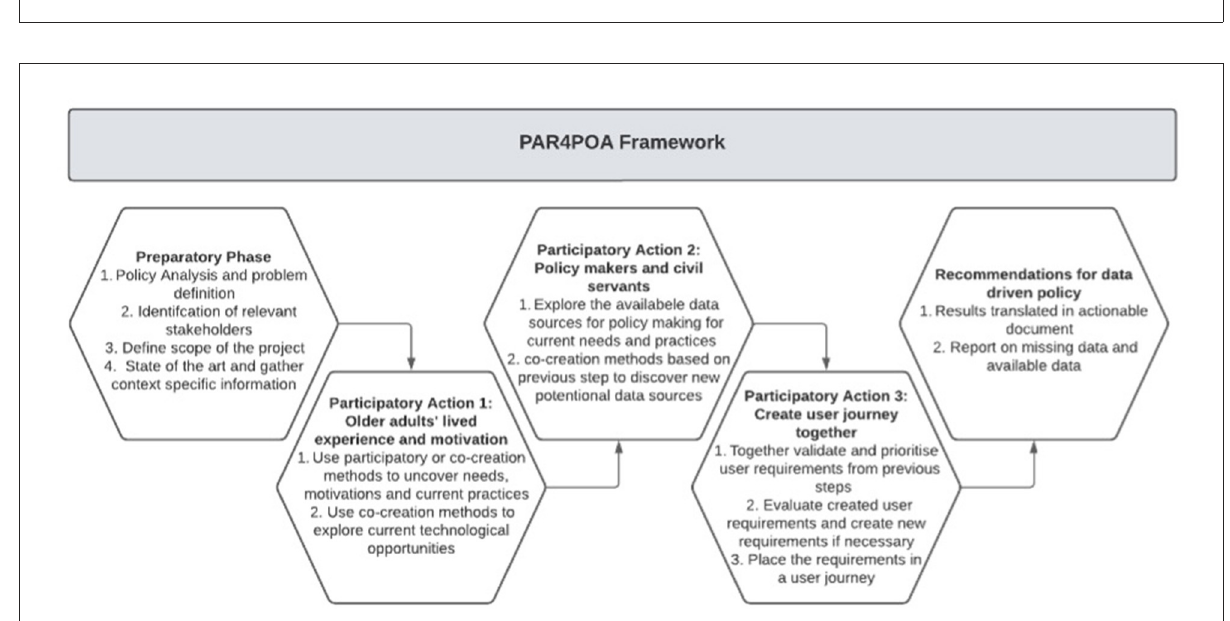
FIGURE3 Overview of the PAR4POA framework demonstrating the link between the various